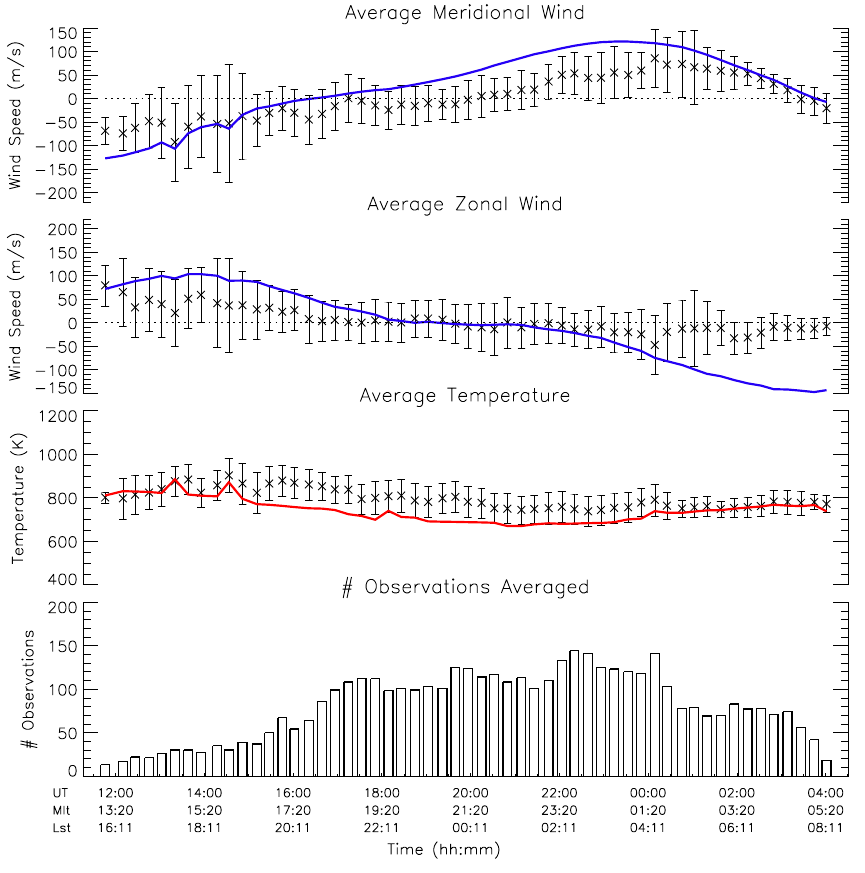
Fig. 6. Average winds and temperatures observed under all geomagnetic conditions. Error-bars indicate the 1- σ uncertainties of the observed distributions within each time bin. Solid blue and red lines show model output (HWM93 for winds, NRLMSISE-00 for temperatures) for the averaged geomagnetic